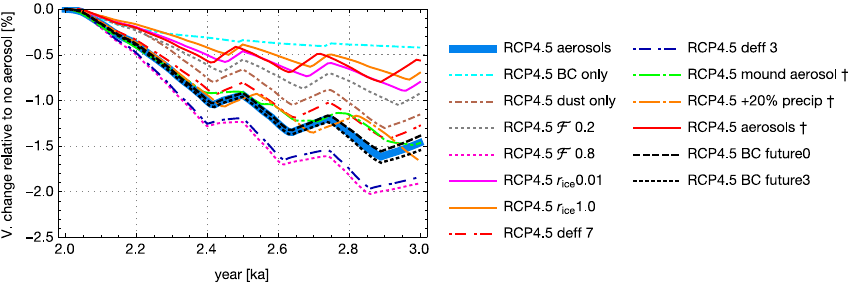
Figure 10. Simulations with RCP4.5 forcing: ice sheet volume change with aerosols (for different parameter settings) compared to the standard RCP4.5 run without aerosols. Simulations marked with a † are compared to a different reference; see main